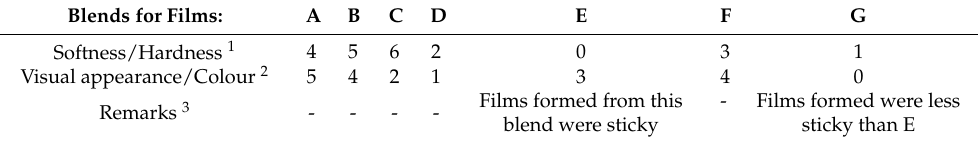
Table 2. The feel, visual appearance (colour) of the blends after mixing in a plastograph. Blends for